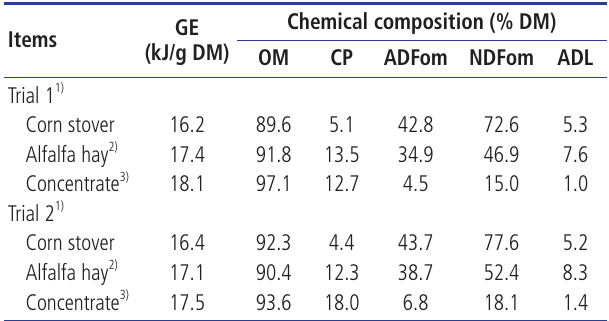
Table 1. Gross-energy concentrations and chemical compositions of feed ingredients in experimental diets for Simmental beef calves in Gansu province, China